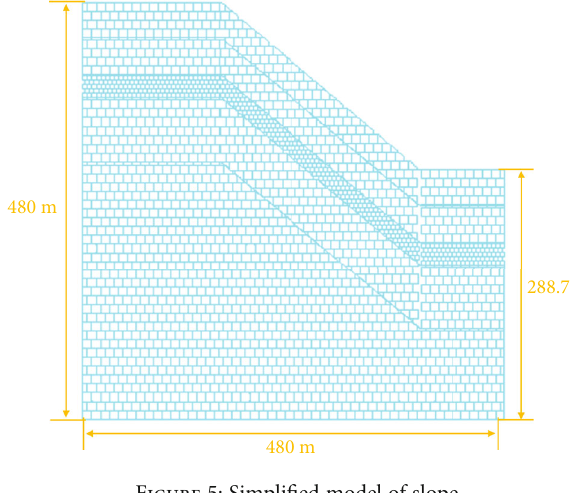
Figure 6: Schematic diagram of model boundary